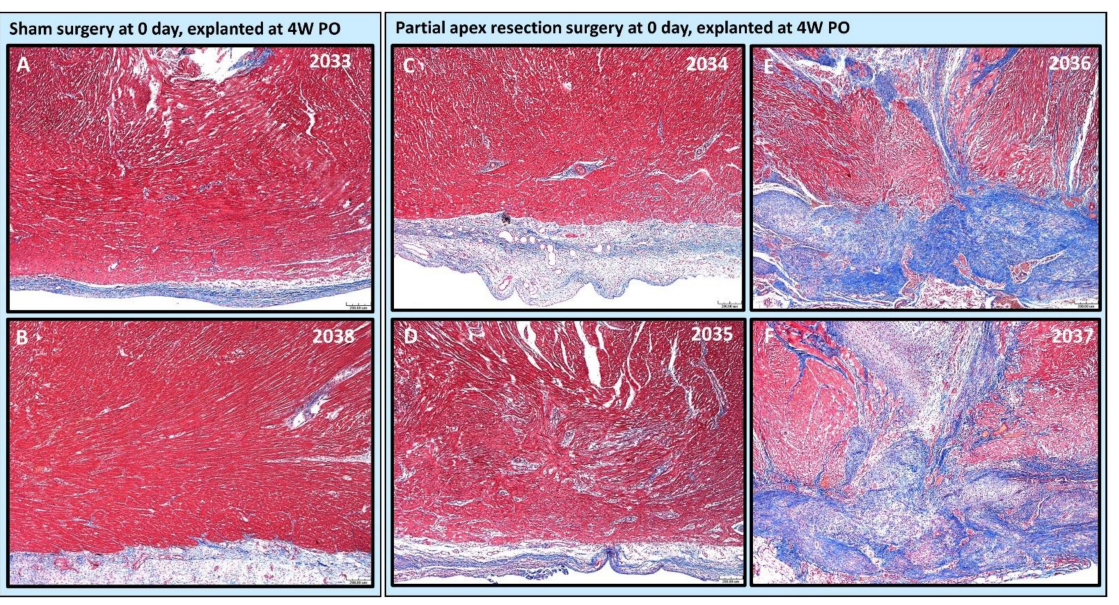
Figure 6. Partial apex resection surgery at 0 days and heart explanted at 4W PO-Masson’s Trichrome histology of 0-day control hearts and 0-day surgery hearts. Heart explants were obtained four weeks post-operation (4W PO). ( A ) Zero-day control (sham) heart from piglet #2033. ( B ) Zero-day control (sham) heart from piglet #2038. ( C ) Zero-day surgery heart from piglet #2034. ( D ) Zero-day surgery heart from piglet #2035. ( E ) Zero-day surgery heart from piglet #2036. ( F ) Zero-day surgery heart from piglet #2037. Histological images were taken at 4 × magnification (Scale bar = 200 µ m). Masson’s Trichrome: red–muscle; blue–collagen.